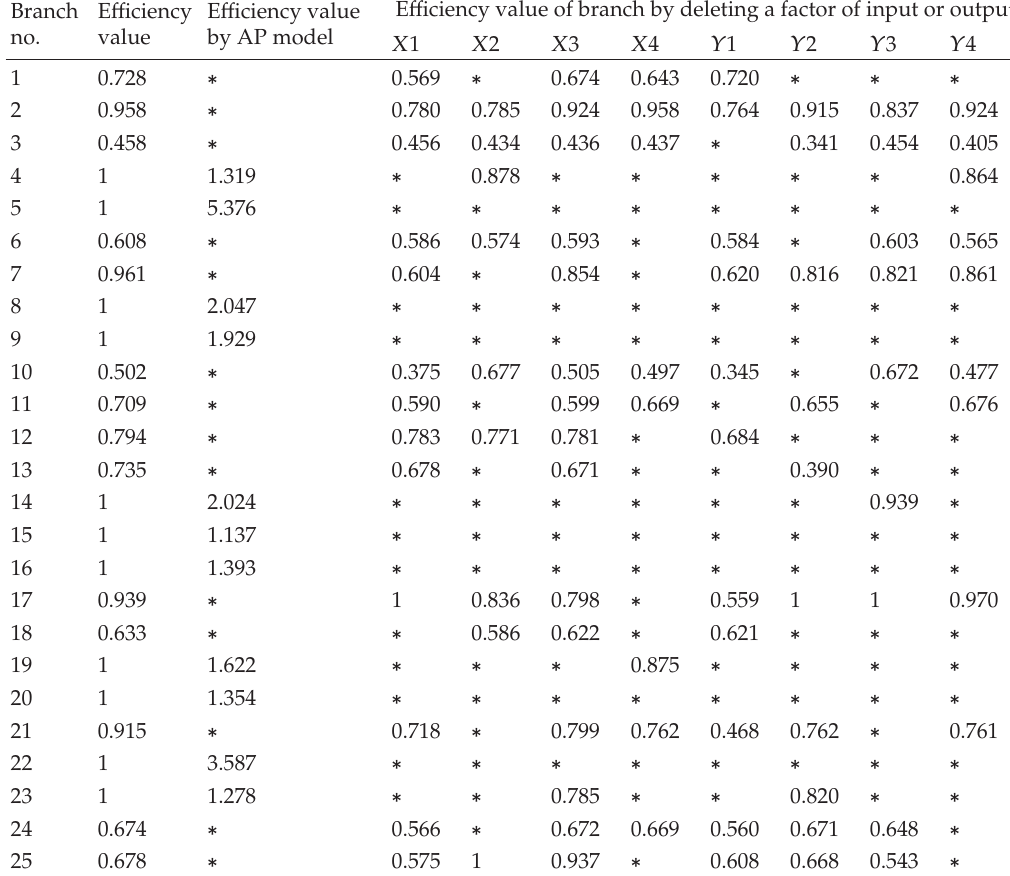
Table 2: E ffi ciency value of DMUs based on CCR model with similar value